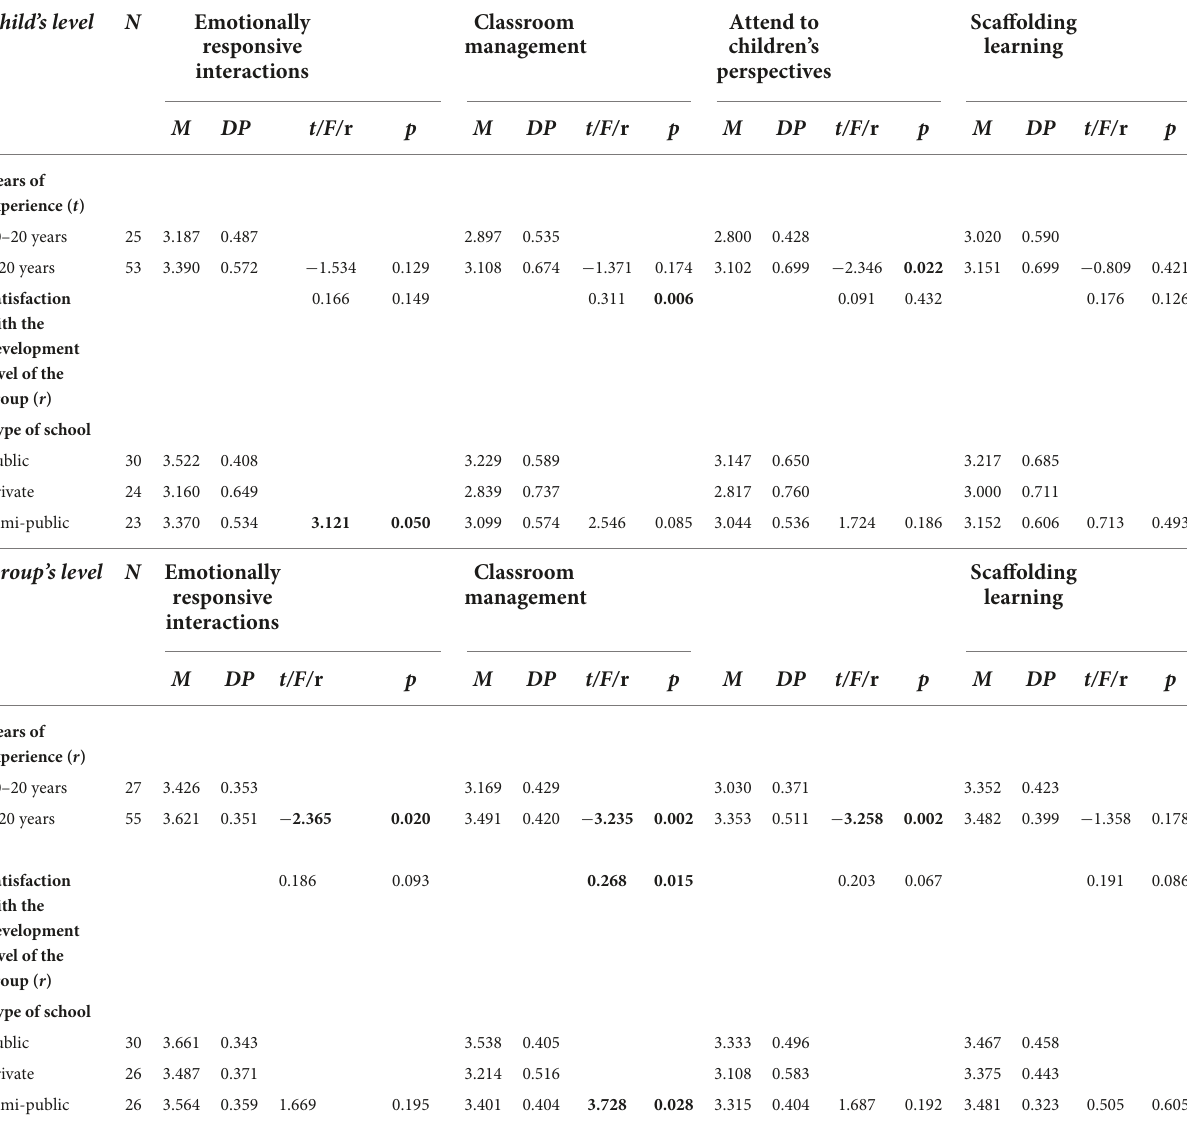
TABLE 7 Individual and contextual variables significantly associated with the feasibility of each dimension at the child and group’s levels. Child’s level N Emotionally